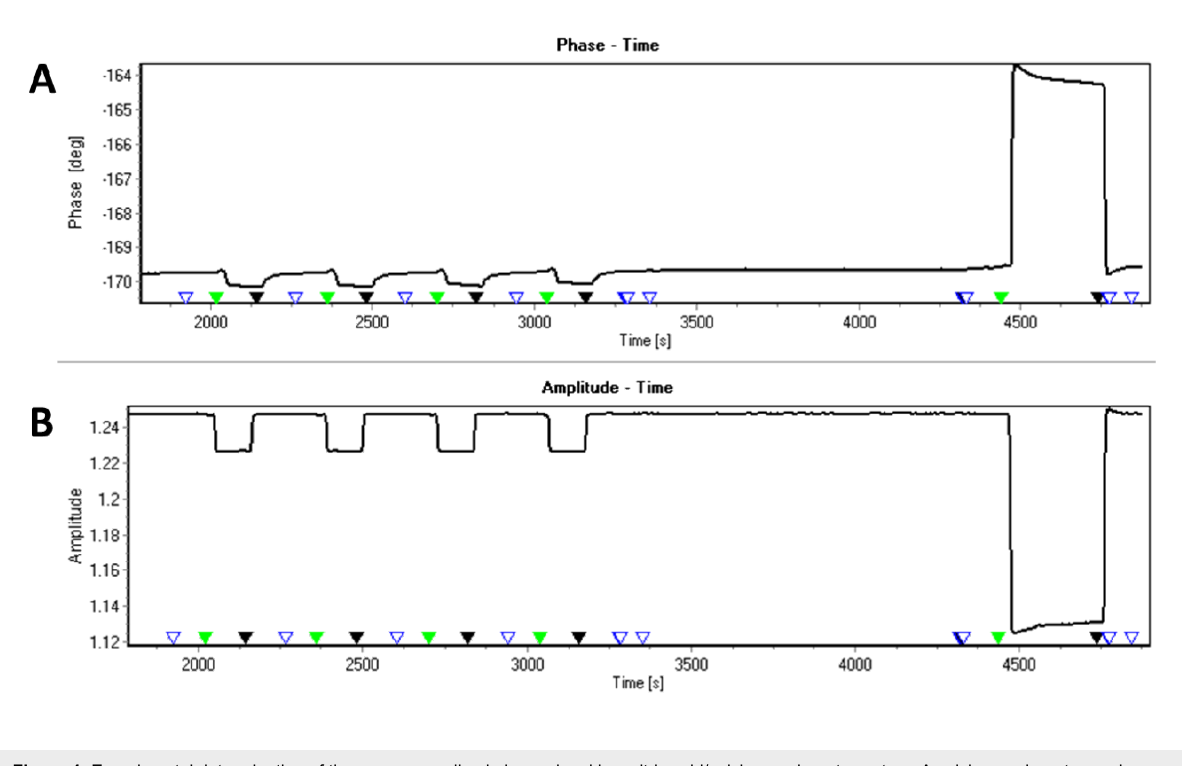
Figure 4: Experimental determination of the mass normalized phase signal in a citric acid/calcium carbonate system. A calcium carbonate running buffer was used here. Citric acid was injected for 120 seconds, followed by regeneration intervals of several minutes. Finally, 5% glycerol were injected. Green triangles, injection start; black triangle, end of